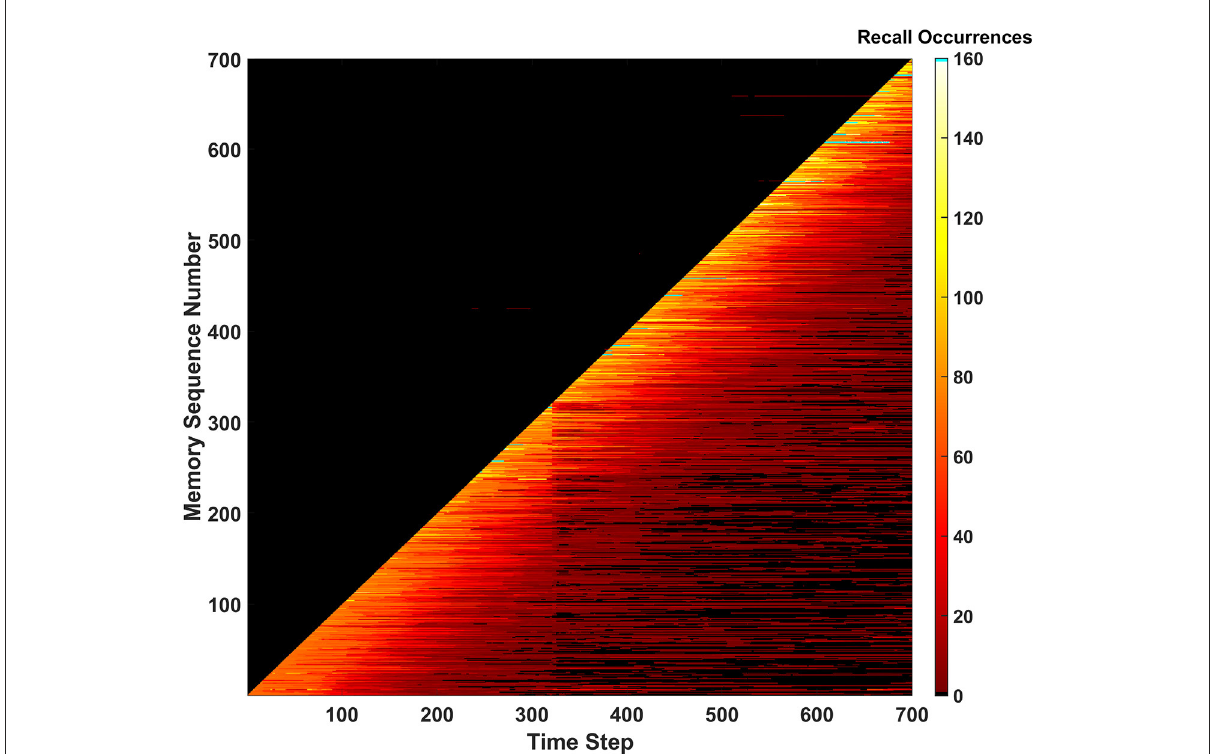
FIGURE13 Recall occurrences heatmap for the behavior ensemble simulation of the SAN. Signatures of both the erase and forgetting behaviors can be seen in the forgetting shelf and fracture in the heatmap shortly after the 300th time step. All predictions above the diagonal were determined to be not made by the predictive behavior.